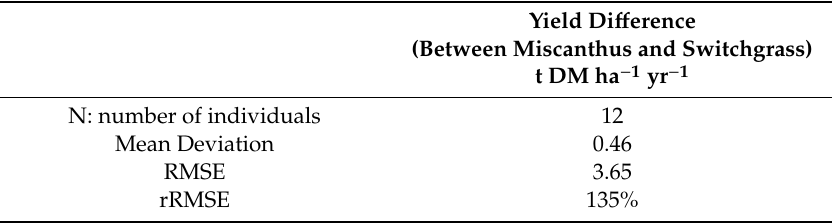
Table 5. Statistical analyses of the difference between the yields of miscanthus and switchgrass crops. Yield Difference (Between Miscanthus and